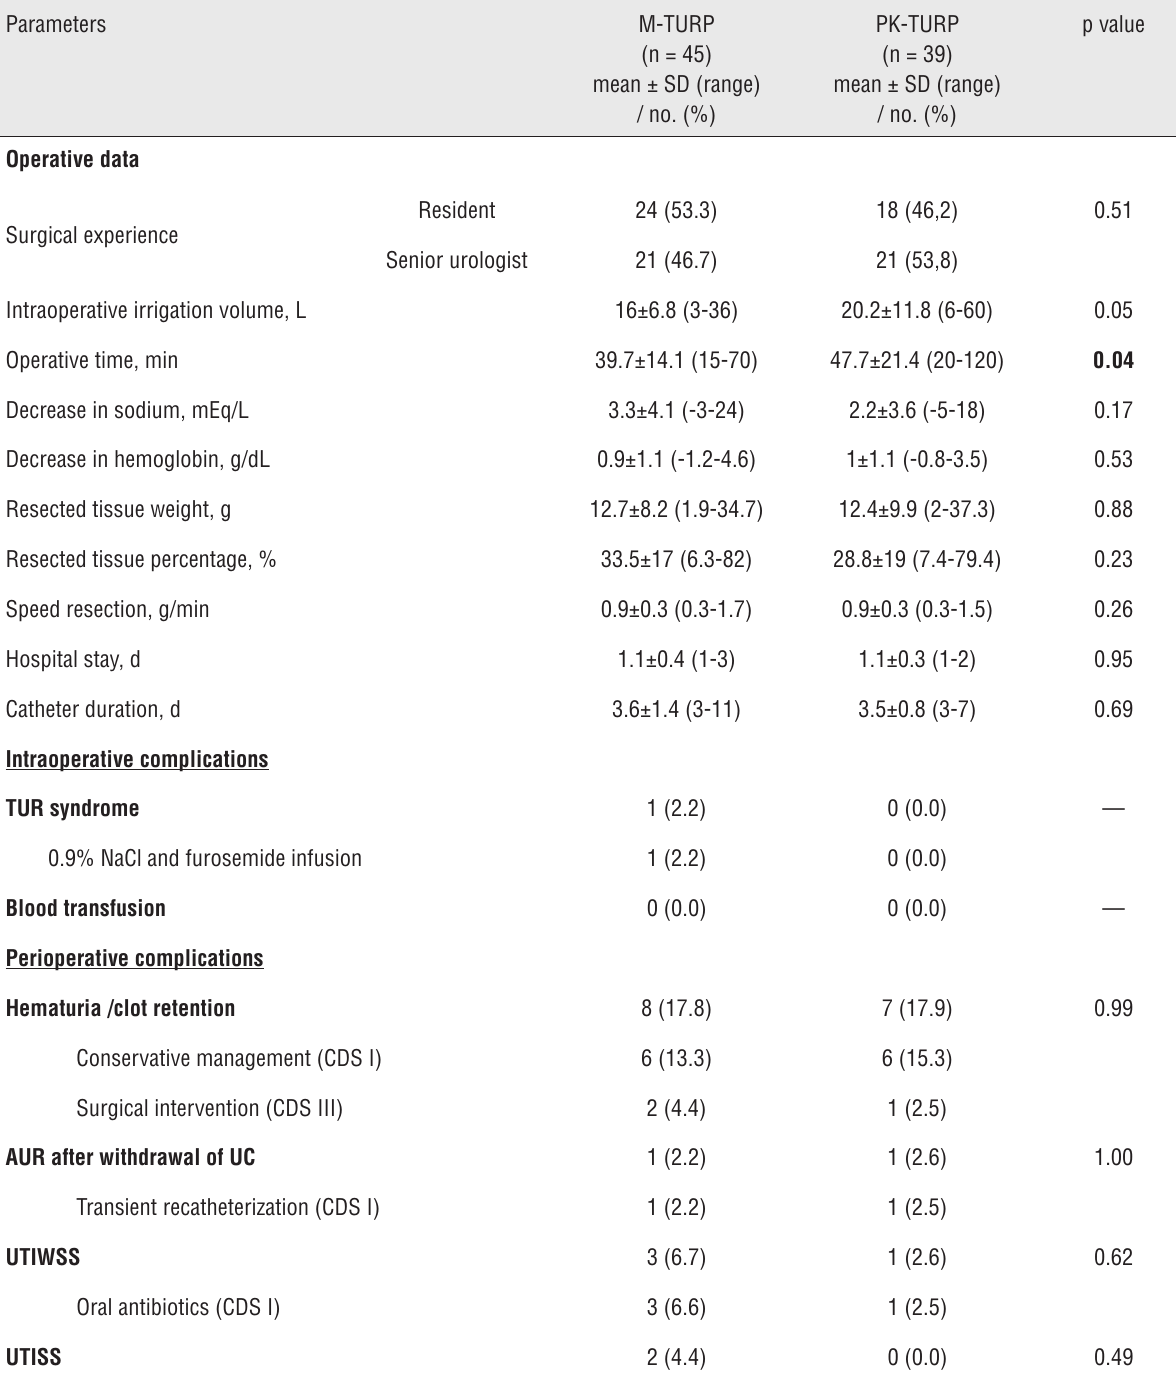
Table 2 - Operative data and intra/perioperative complications stratified by treatment